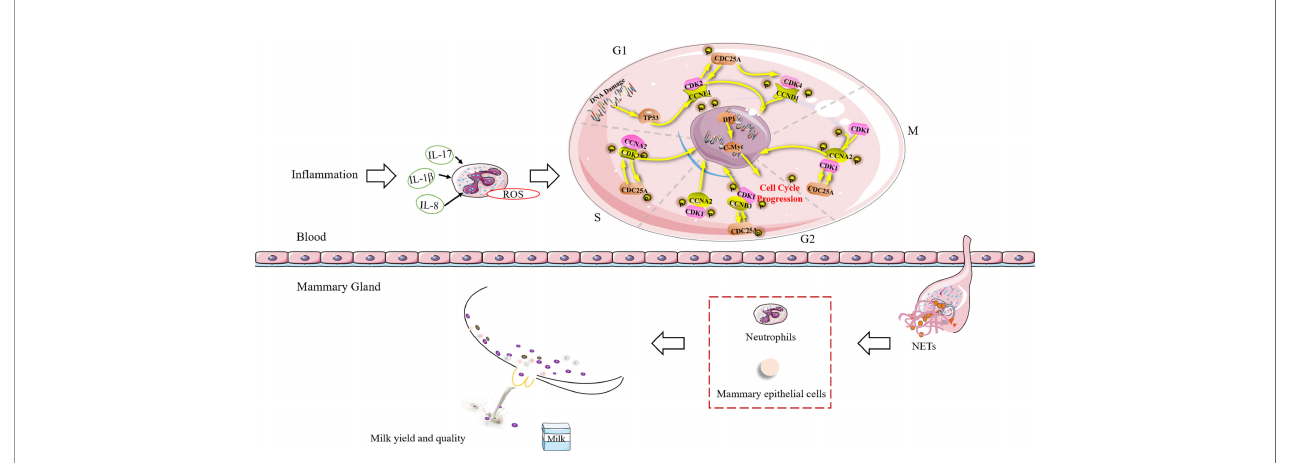
FIGURE 6 | Schematic diagram of the relationship between NET formation in blood and the risk of mastitis in dairy cows during the transition period. TP53 , Tumor suppressor p53; CCNA2 , Cyclin A2; CCNB3 , Cyclin B3; CCND1 = Cyclin D1; CCNE1 , Cyclin E1; CDC25A , Cell division cycle 25A; CDK1 , Cyclin-dependent kinase 1; CDK2 , Cyclin-dependent kinase 2; CDK4 , Cyclin-dependent kinase 4; DP1 , D-prostanoid receptor 1; G1, G2, M, and S, different stages of cellular differentiation; IL, interleukin; NETs, neutrophil extracellular traps; ROS, reactive oxygen